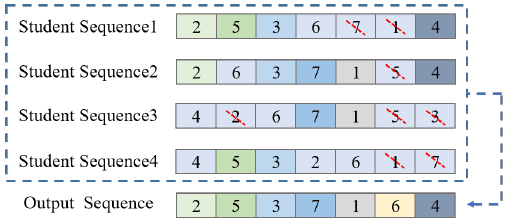
Figure 5. Middle student algorithm.